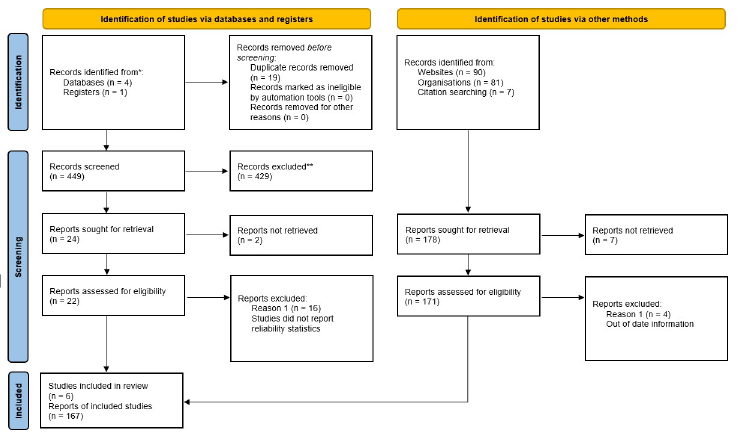
Fig 1. PRISMA flow